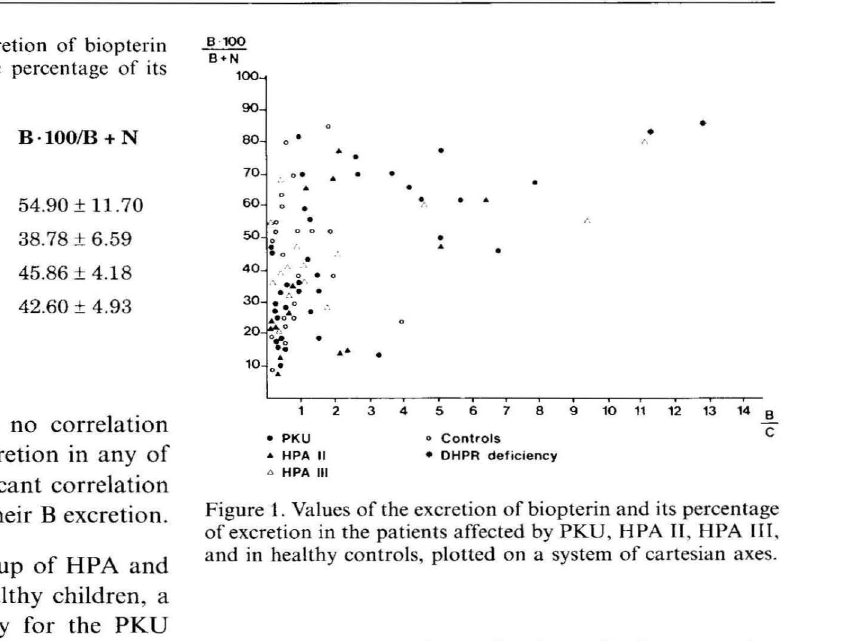
Table 1. Mean ± SEM of the urinary excretion of biopterin (mmol Blmol C) and mean ± SEM of the percentage of its excretion.